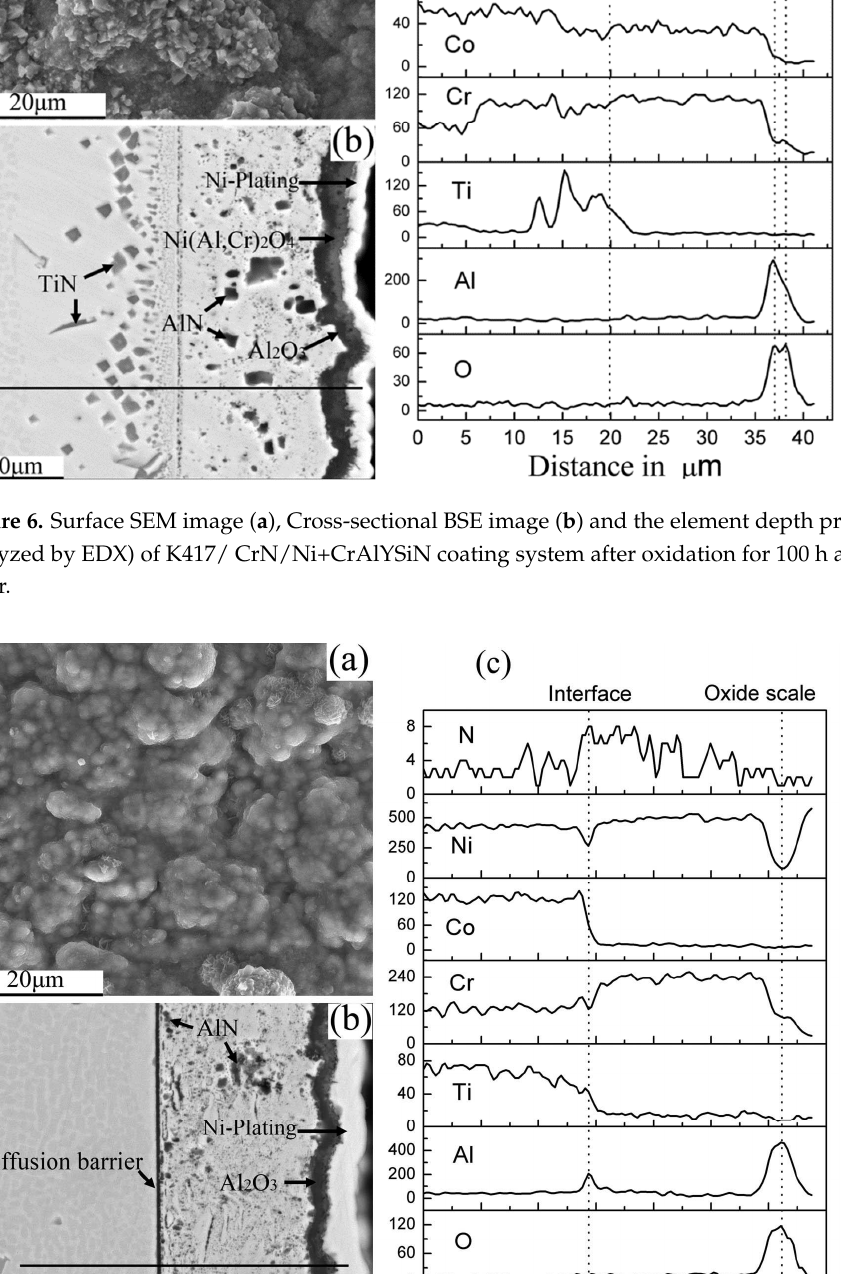
Figure 8. Surface SEM image ( a ), Cross-sectional BSE image ( b ) and the element depth profiles (( c ), analyzed by EDX) of K417/TiN/Ni+CrAlYSiN coating system after oxidation for 100 h at 1000 °C in air.